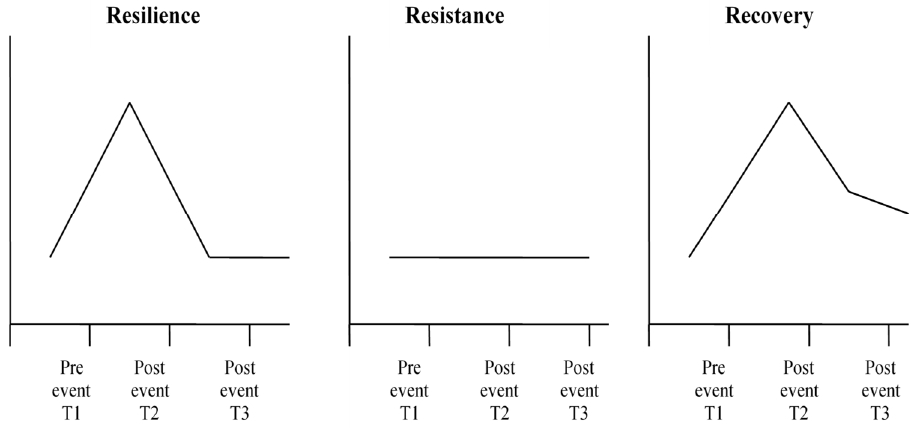
Figure 1. Hypothesised trajectories of the course of stress response.